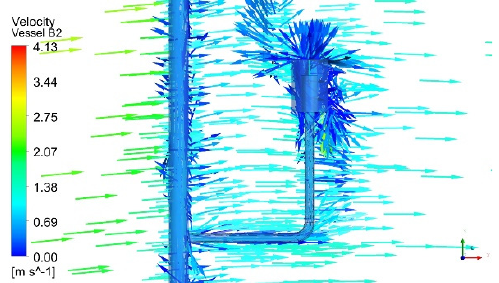
Figure 13. Internal flow (velocity vectors), low-pressure section.